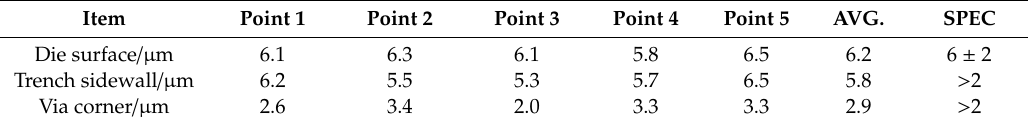
Table 8. The thicknesses of PA in die surface, trench sidewall and via corner in second PA